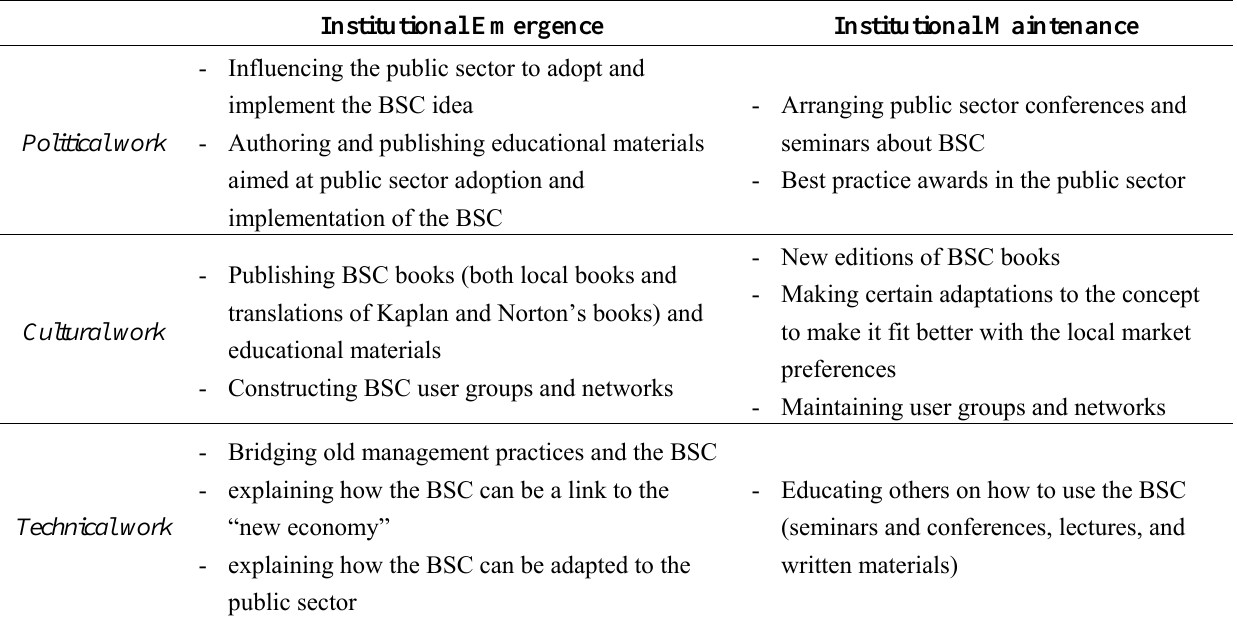
Table 6. Examples of institutional work carried out by supply-side actors (Source: [113] (p.